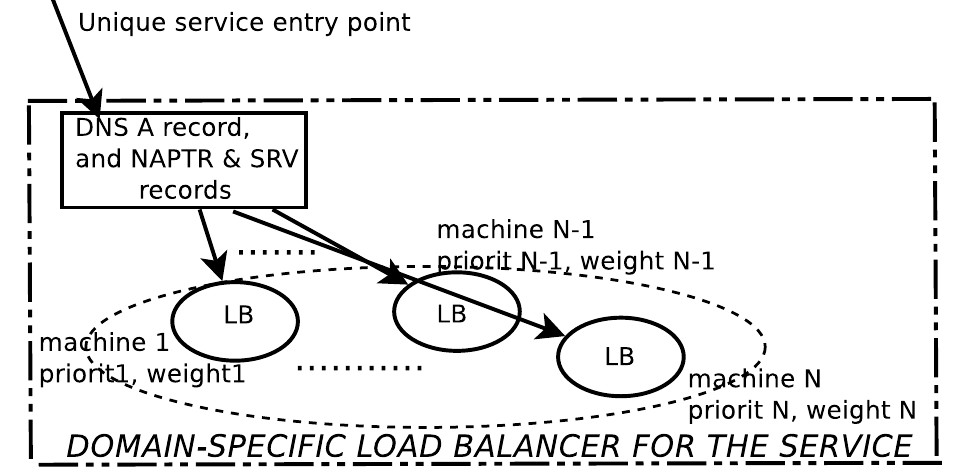
Figure 1. Single entry point for the DNS